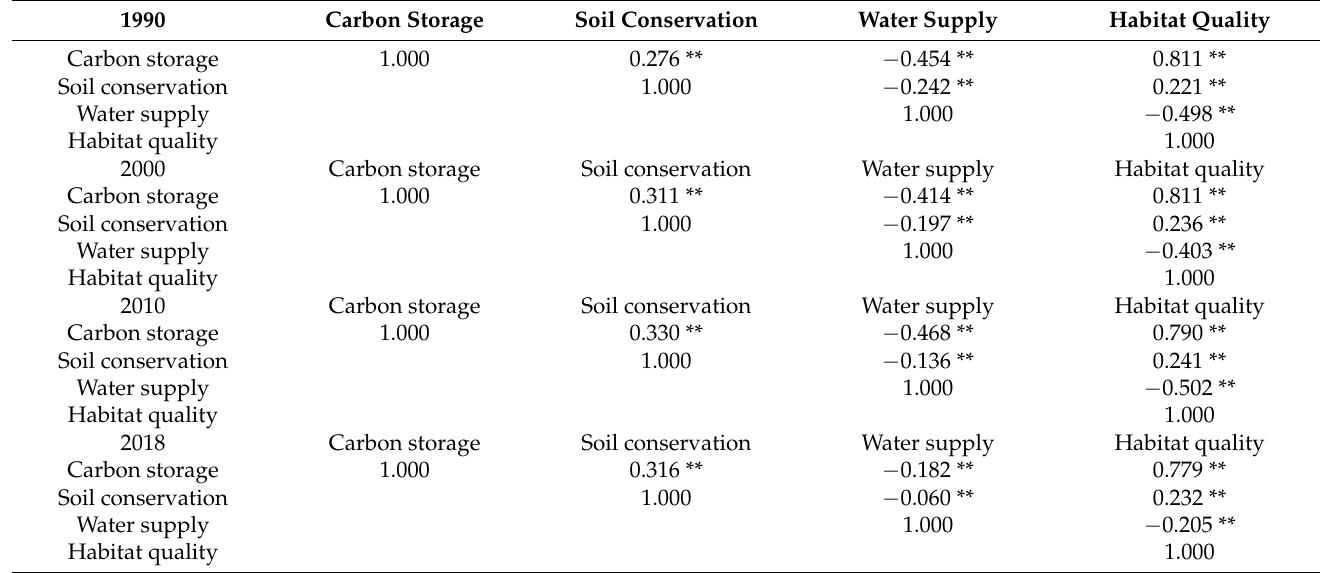
Table 3. Correlation of grassland ecosystem services between 1990 and